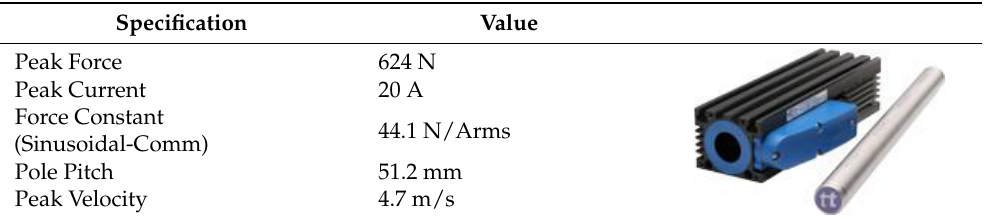
Table 1. Dunkermotoren GmbH STA-2508 Linear Servo Tube Specifications (2022) https://www.dunkermotoren.com/, (accessed on 1 May 2022).